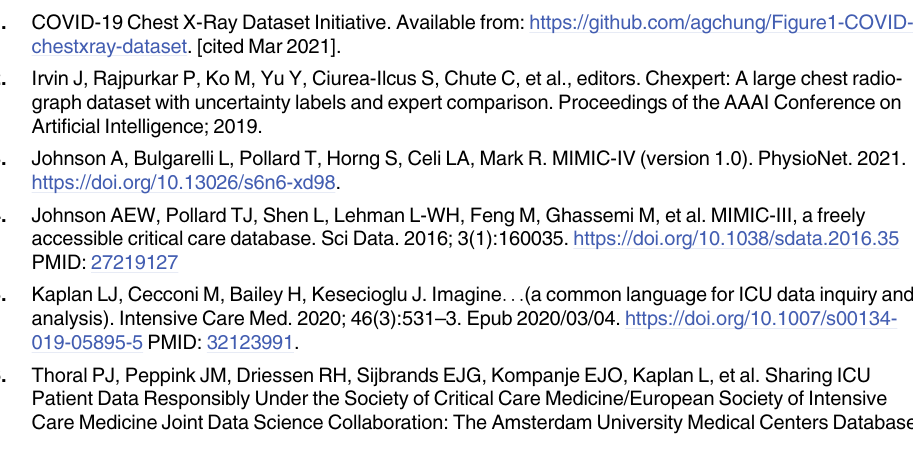
S2 Table. Coded deanonymization and reidentification stories. S3 Table. Complete list of individual cases on media about personal information disclo-